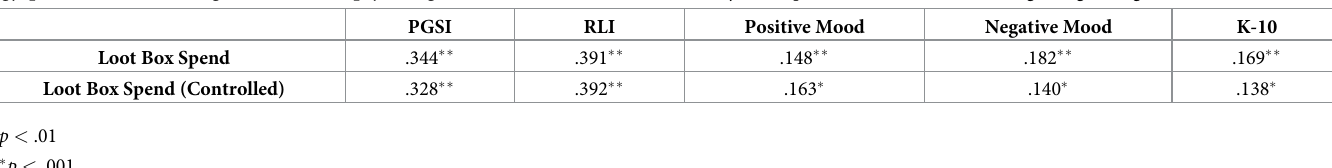
Table 1. Relationships (Spearman’s rho) between loot box spending, Problem Gambling Symptomology (PGSI), the Risky Loot Box Index (RLI), IGD symptomol- ogy, positive mood, and negative mood and psychological distress (K-10). Controlled analyses are partial correlations controlling for age and